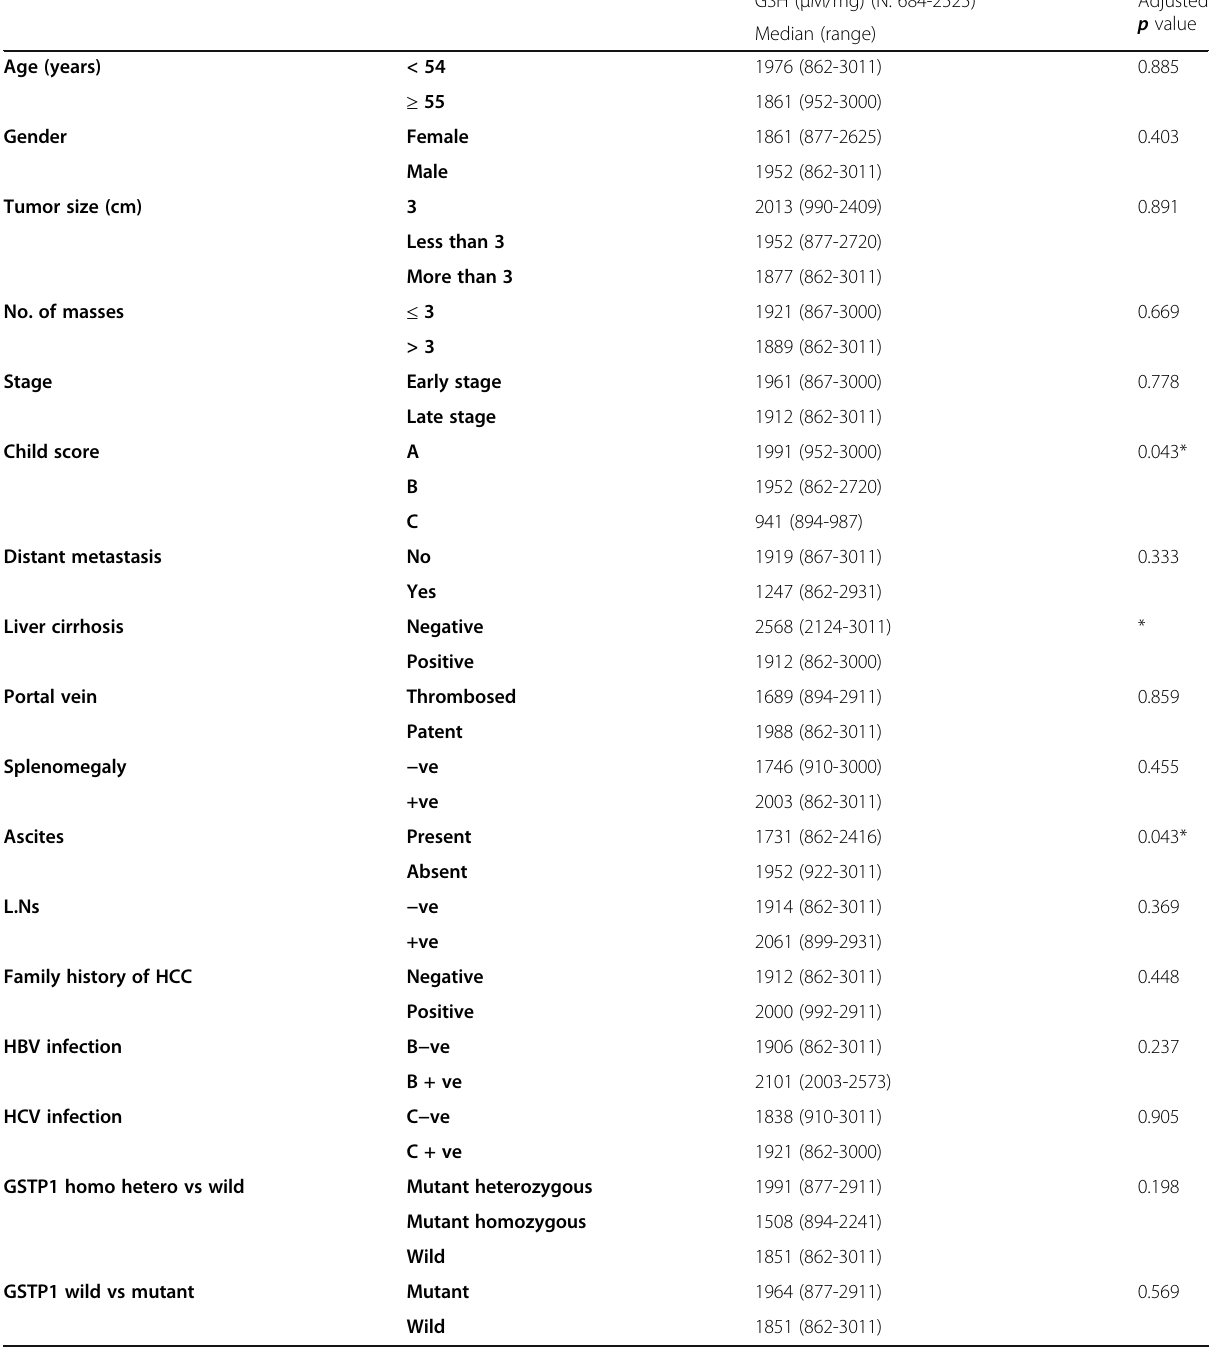
Table 3 Comparison of the plasma levels of reduced glutathione with some prognostic factors of